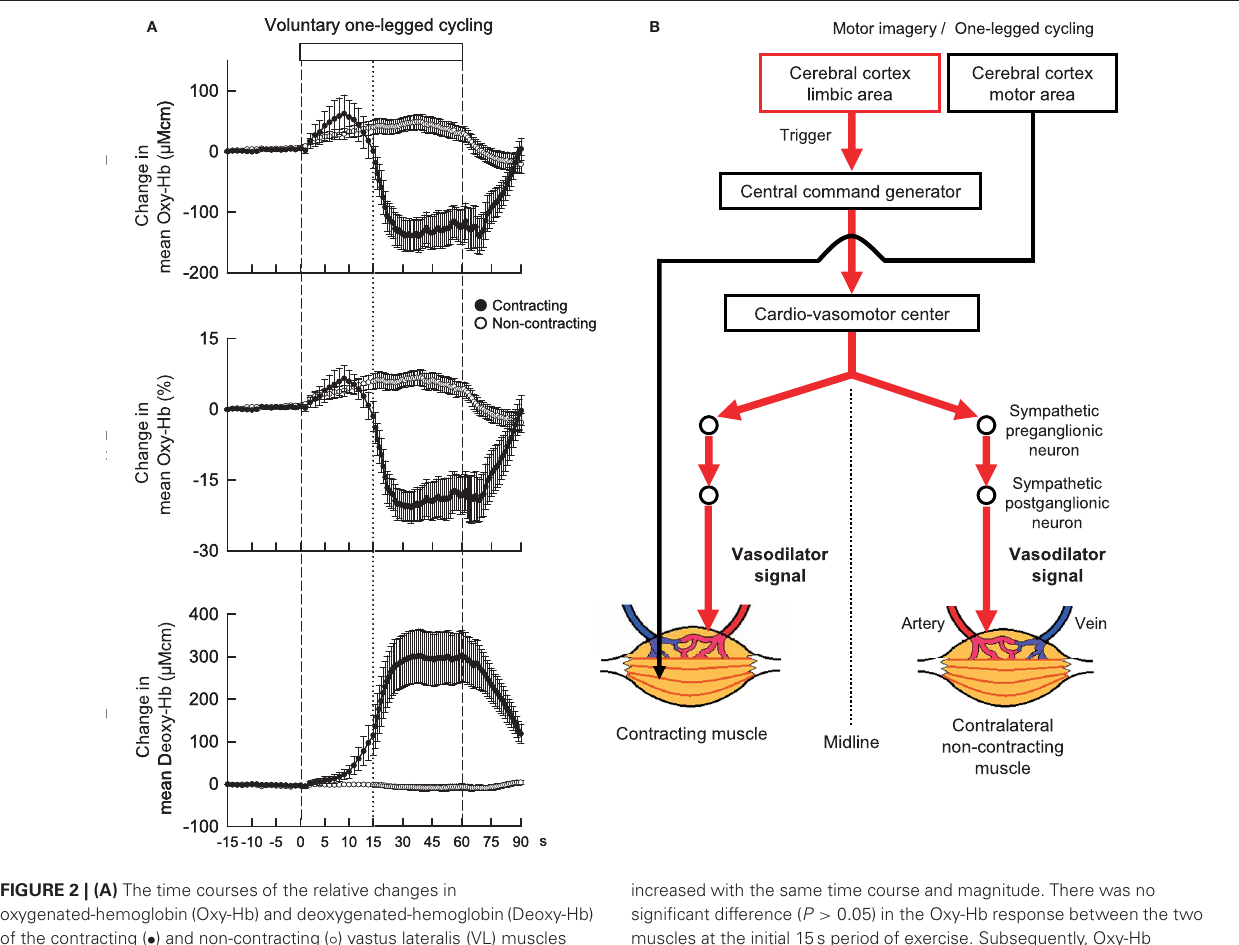
increased with the same time course and magnitude. There was no significant difference ( P > 0 . 05) in the Oxy-Hb response between the two muscles at the initial 15s period of exercise. Subsequently, Oxy-Hb decreased and Deoxy-Hb increased in the contracting VL as long as exercise was continued. Adopted from Ishii et al. (2012) with permission. (B) A hypothesis that centrally-induced vasodilator signal is equally transmitted to bilateral VL muscles at the start of voluntary one-legged exercise in